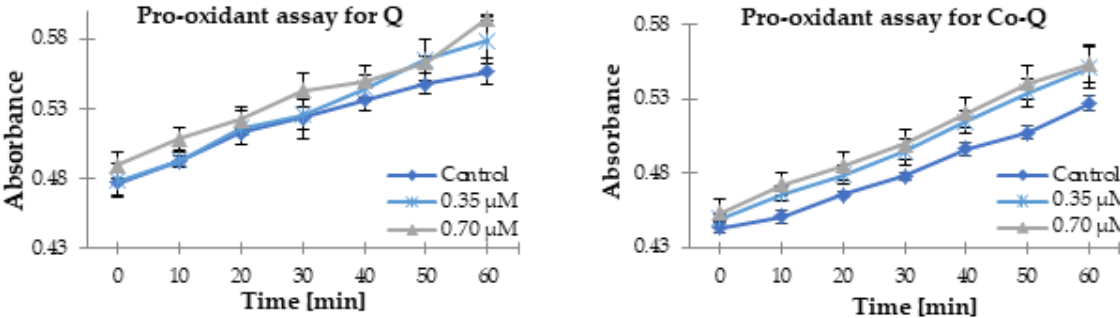
Figure 8. The absorbance ( λ max = 272 nm) obtained in the Trolox oxidation assay measured every 10 min for 60 min for control sample, quercetin (Q) and Co(II)-complex of quercetin (Co-Q). Mean values from three independent experiments ± SD are shown.